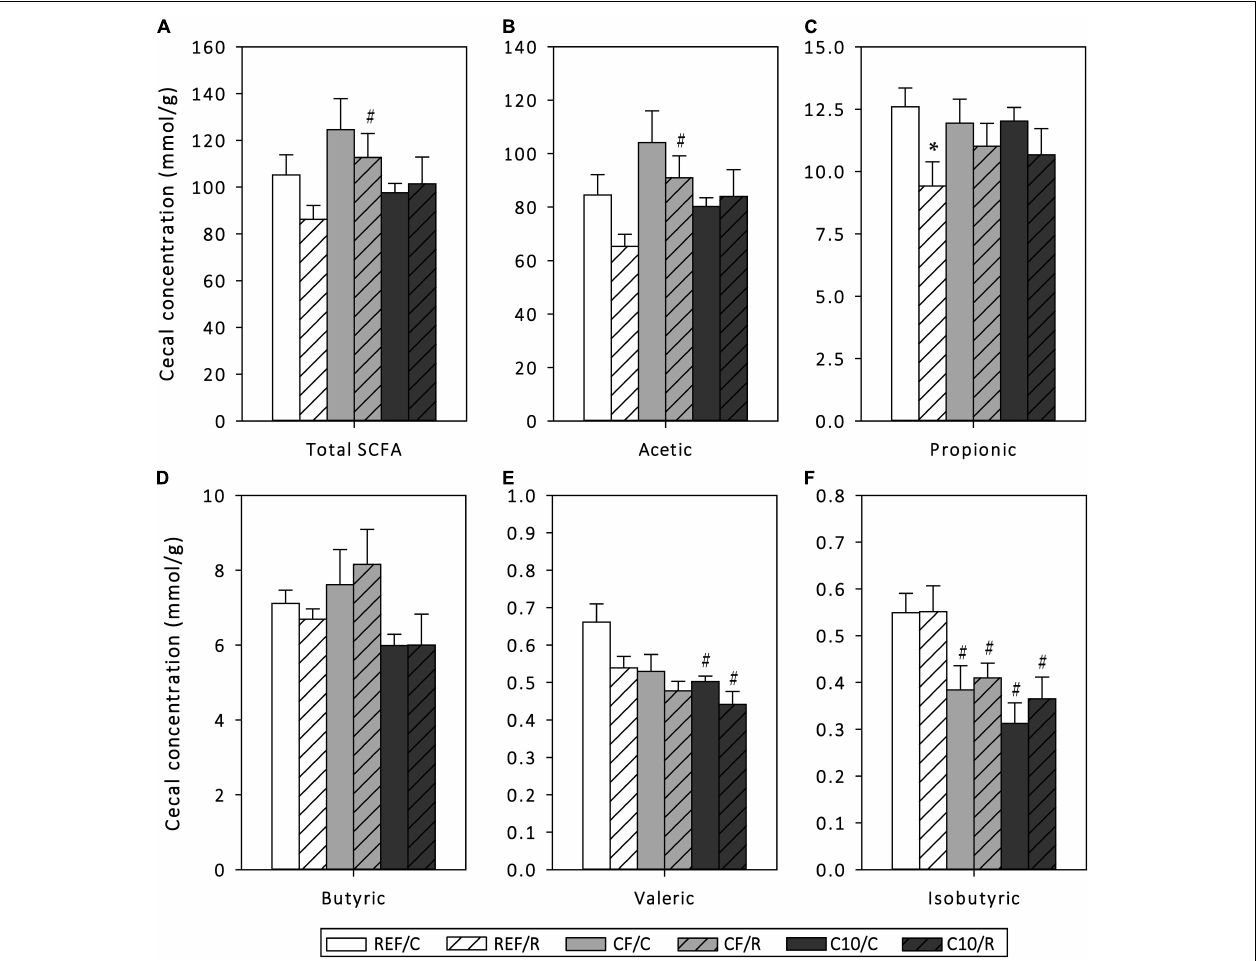
FIGURE 4 | Cecal short-chain fatty acid (SCFA) production: amount of total SCFAs (A) , acetic acid (B) , propionic acid (C) , butyric acid (D) , valeric acid (E) and isobutyric acid (F) in cecal content homogenates. The control (C) groups are represented by smooth bars and the runner (R) groups by striped bars. REF,